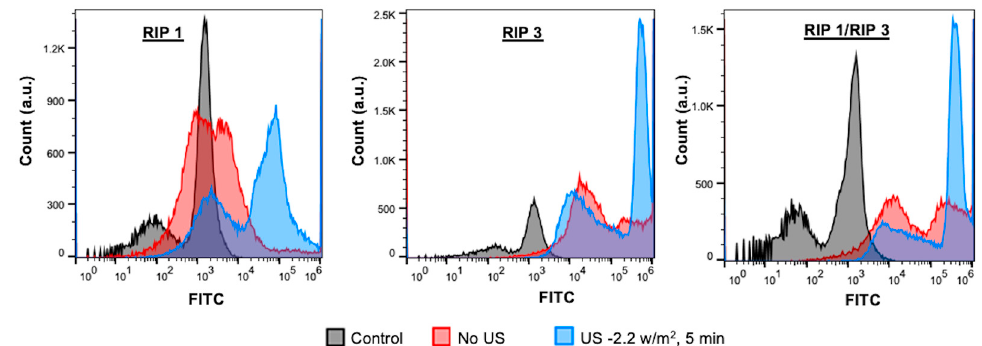
Figure 5. Ultrasound mediated uptake of the aggregates assessed with flowcytometry. The scattering measurements reveal cellular uptake of RIP1, RIP3, and RIP1/RIP3 aggregates were increased in the presence of ultrasound 2.2 W/cm 2 , 5 min.